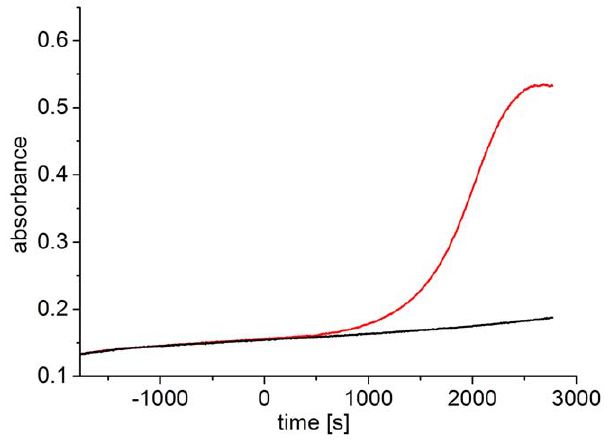
Figure 4. Scattering increase of dark-adapted and red-irradi- ated Agp1 at 50 6 C. Dark-adapted Agp1 was placed in a 50- u C cuvette and absorption was continuously monitored at 500 nm. One sample (red line) was irradiated with red light (655 nm, 20 m mol m 2 2 s 2 1 ) starting at t=0. The other sample (black line) was kept in darkness.